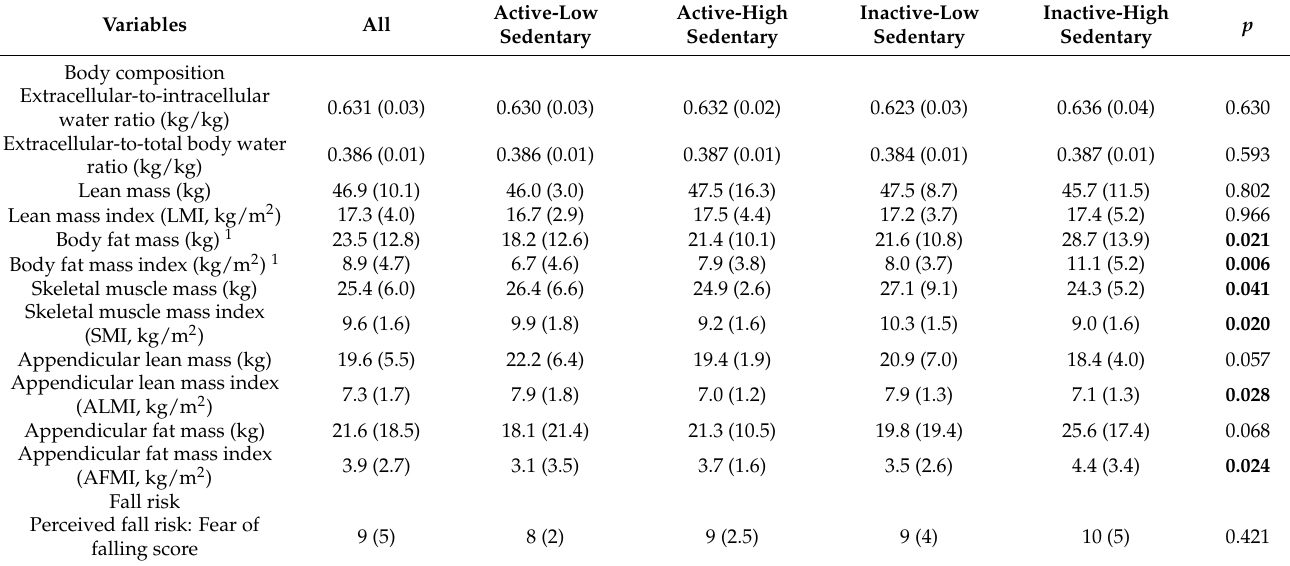
Table 2. Results from the bioelectrical impedance analysis and fall risk